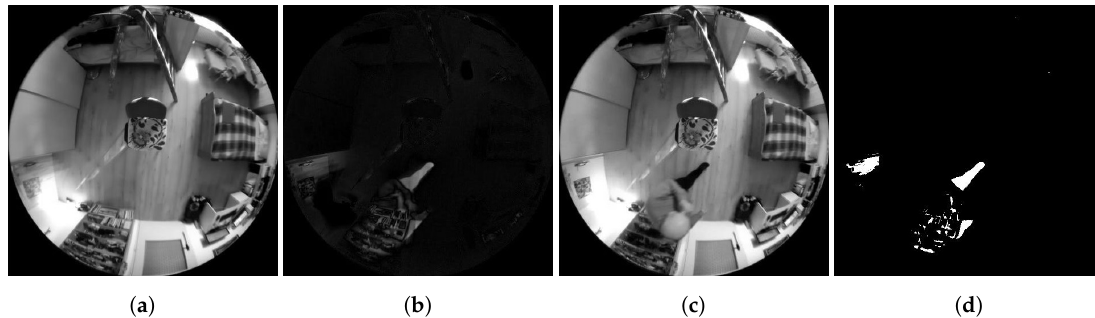
Figure 5. Examples of Method 1.2. functionality. ( a ) Background frame. ( b ) Difference in brightness between the currently checked frame and the background frame. ( c ) Currently checked frame.